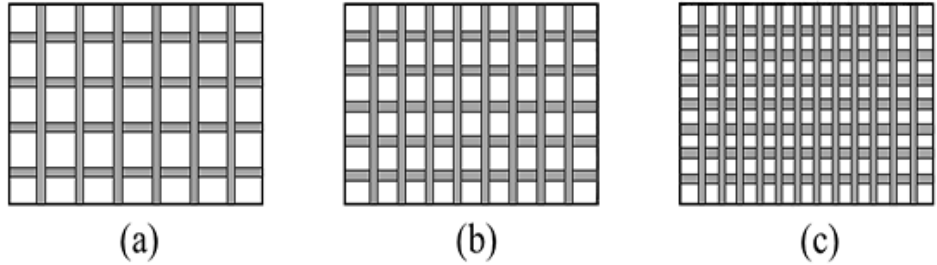
Figure 2. Schematic diagram of the processing of the biomimetic sample: ( a ) 3.5 mm; ( b ) 2.5 mm; ( c ) 1.5 mm.